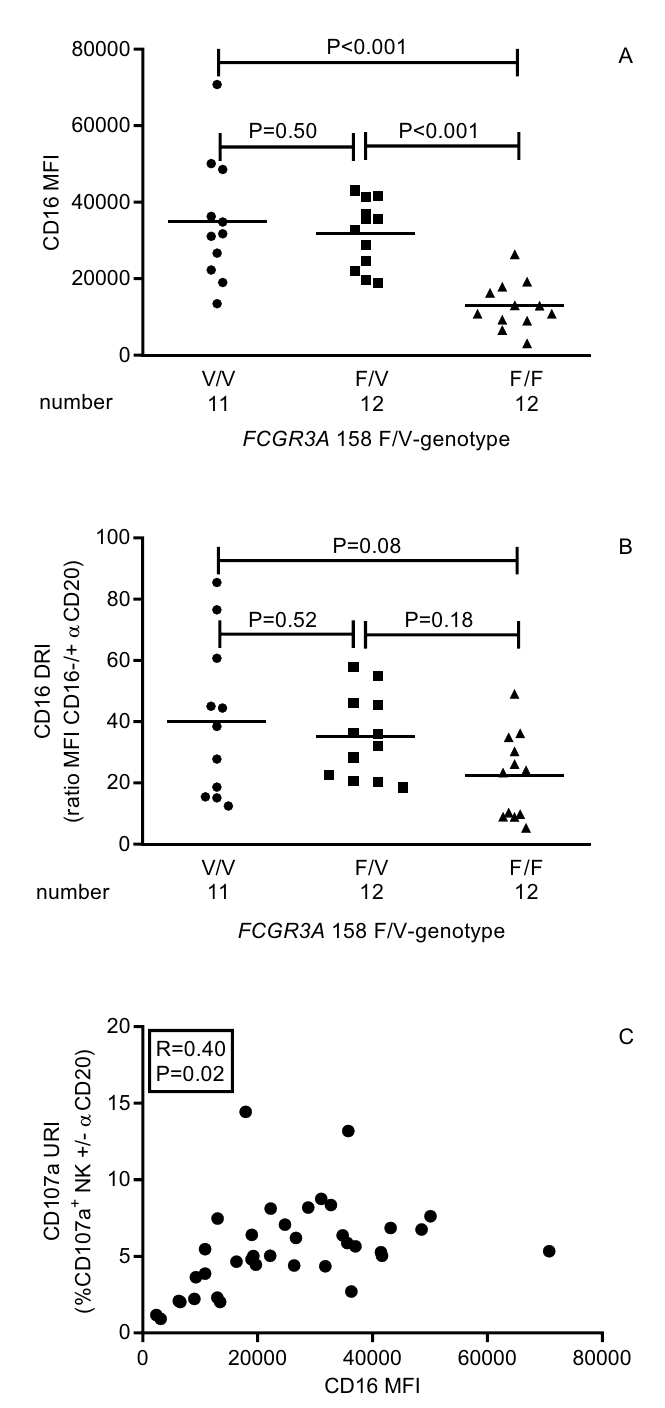
Figure 2. FCGR3A 158 F/V-genotype and CD16-dependent NK cell function. Median fluorescence intensity (MFI) of CD16 by NK cells ( A ) were measured in 35 samples genotyped for FCGR3A 158 F/V. The anti-hCD20- hIgG1-mediated downregulation of CD16 was measured for 35 samples genotyped for FCGR3A 158 F/V ( A ). Circles represent V/V-genotype, squares the F/V-genotype and triangles the F/F-genotype. The horizontal line represents the mean value per genotype. The baseline MFI of CD16 on circulating CD16 + NK cells, displayed on the X-axis, was associated to the anti-hCD20-hIgG1-mediated upregulation of CD107a, displayed on the Y-axis for these 35 samples ( C ). Differences between the genotypes were analyzed by the parametric one way Anova, followed by the Bonferroni’s multiple comparison test to determine where significant differences were present. P values < 0.05 were considered statistically